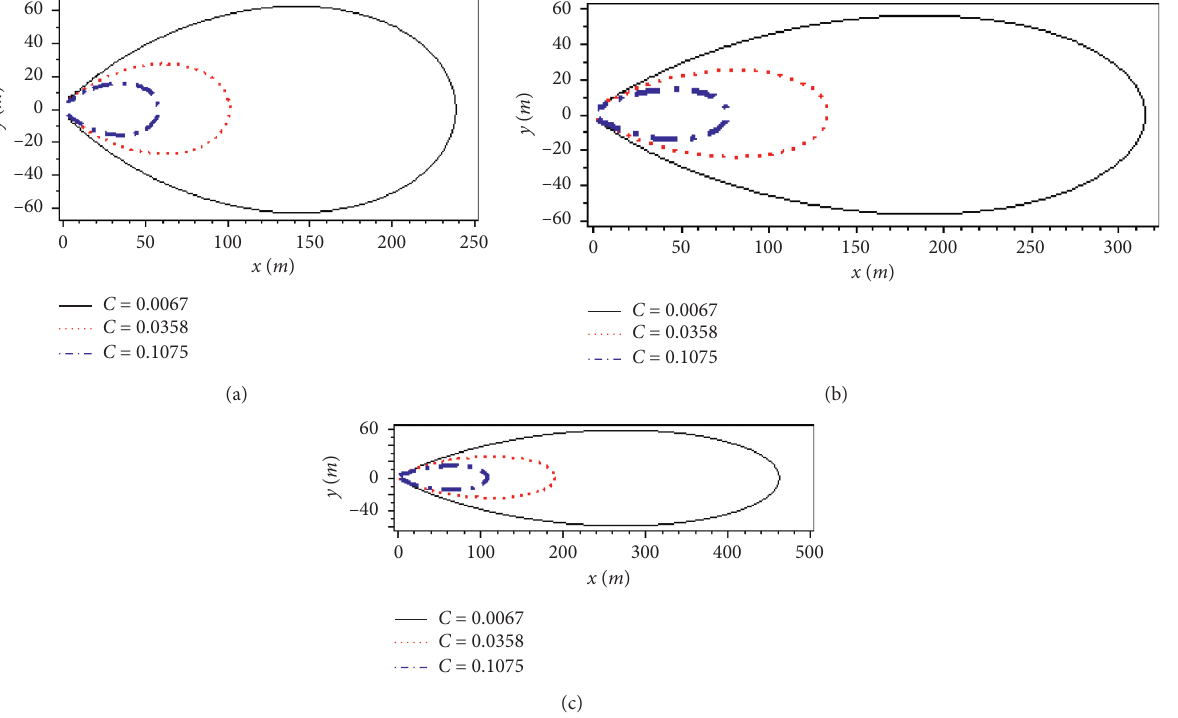
Figure 11: Concentration contours of continuous gas diffusion with different atmospheric classes ( Q � 173kg/s and u � 2m/s). (a) At- mospheric stability class is B. (b) Atmospheric stability class is C. (c) Atmospheric stability class is